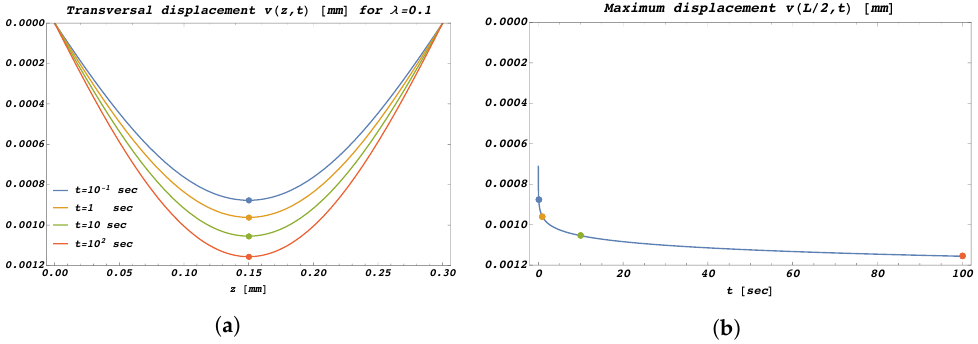
Figure 2. Displacements of nonlocal micro-beam in epoxy resin with λ = 0.1. ( a ) Vertical displacement for different time step; ( b ) Time evolution of displacement at the mid-point.